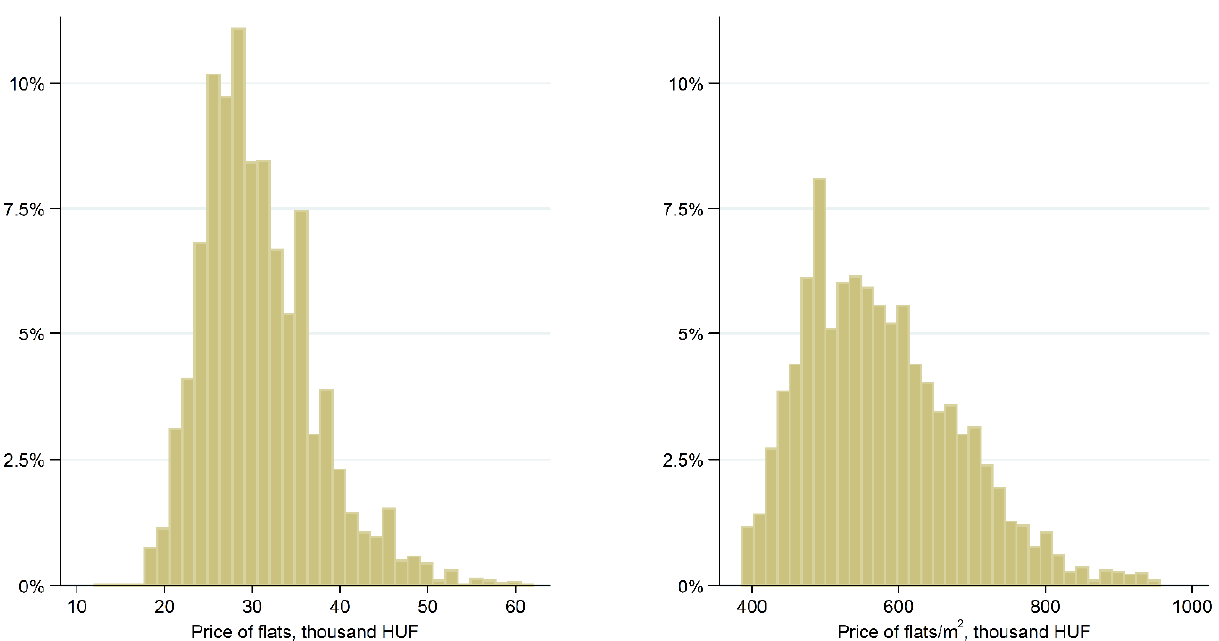
Figure 3. Distribution of flat prices.